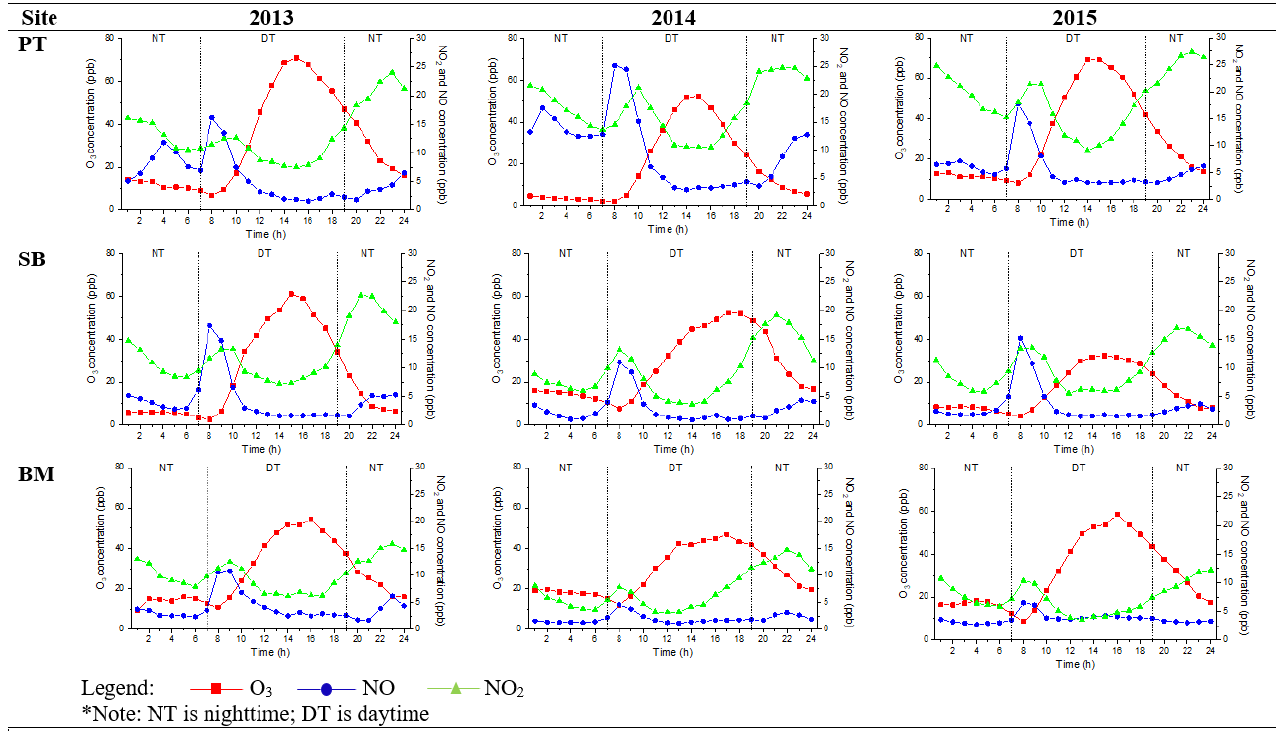
Figure 2. The mean concentrations of O 3 , NO 2, and NO, during daytime (DT) and nighttime (NT), at urban and suburban sites in 2013, 2014, and 2015.